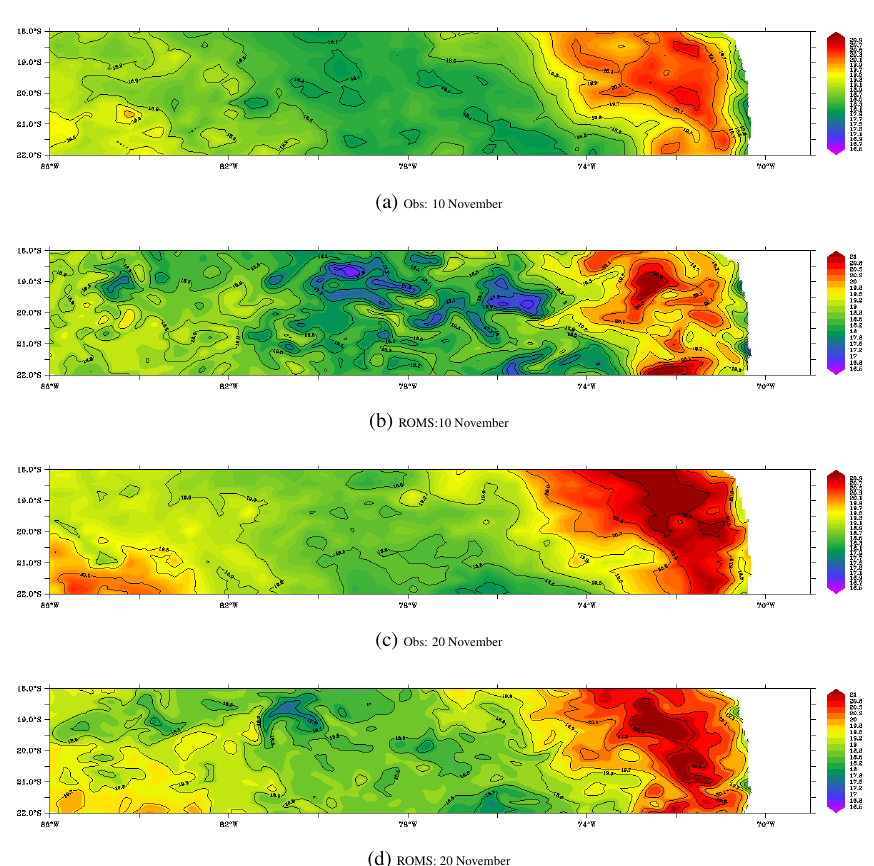
Fig. 10. SST (in ◦ C) from NOAA Optimally Interpolated observations in (a) and (c) and SST from ROMS with the model velocities overlaid for the days 10 th and 20 th November 2008.